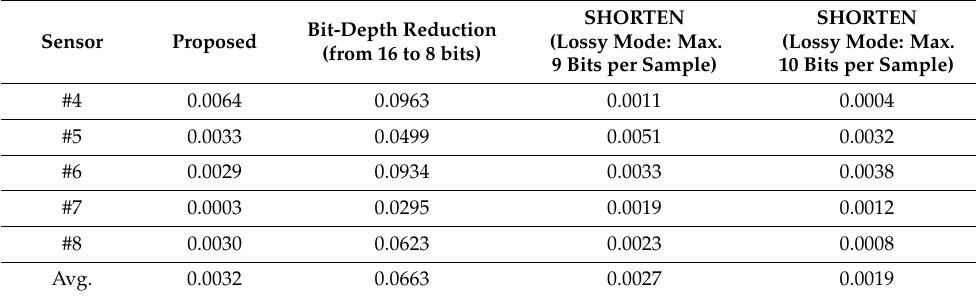
Table 7. Comparison of root mean square error (RMSE) between the original and processed acoustic sensor signals for the proposed method.